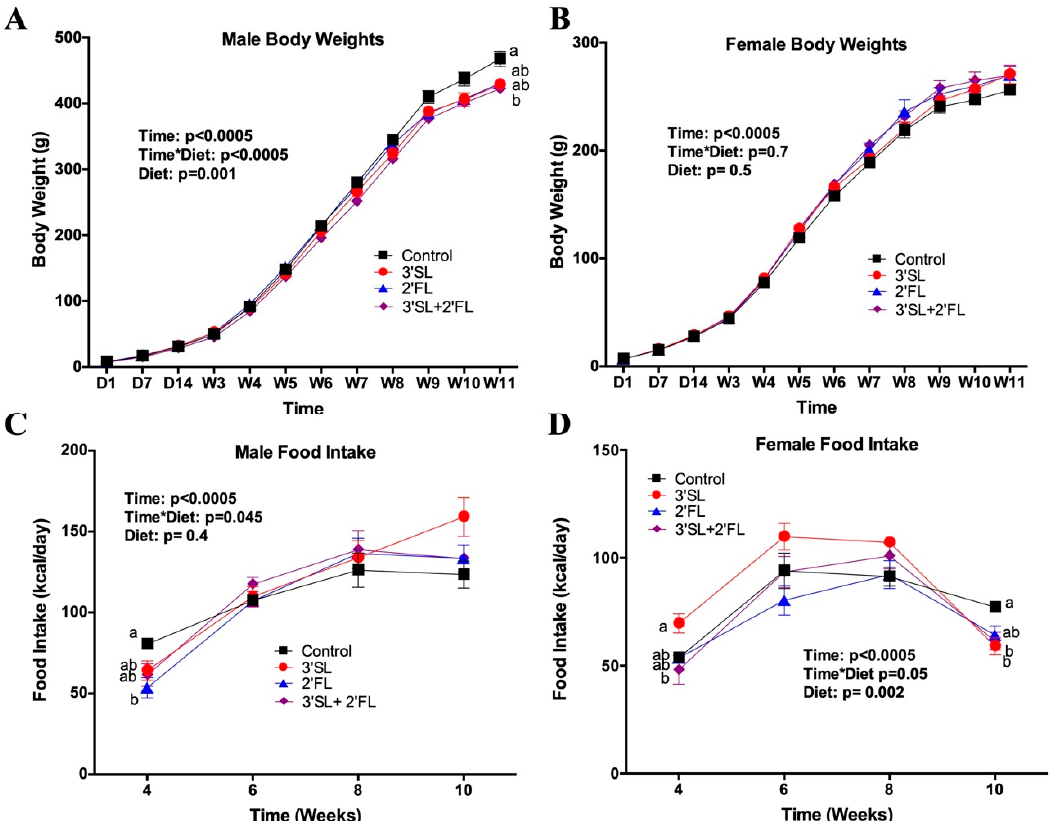
Figure 1. Body weight of ( A ) male and ( B ) female rats, as well as food intake for ( C ) male and ( D ) female rats fed the AIN-93 diet fortified with 3 (cid:48) sialyllactose (3 (cid:48) SL), 2 (cid:48) fucosyllactose (2 (cid:48) FL), both, or neither for eight weeks. Values are means ± standard error of the mean (SEM), n = 8–10. In the overall model, there was a significant sex e ff ect for body weight ( p = 0.001) and food intake ( p = 0.001); therefore, subsequent analysis was performed in males and females separately. Within males and females, the superscripts a, b are used to depict di ff erences between groups, where groups without a common superscript di ff er ( p < 0.05). Control: AIN-93; 3 (cid:48) SL: AIN-93 + 3 (cid:48) sialyllactose; 2 (cid:48) FL: AIN-93 + 2 (cid:48) fucosyllactose; 3 (cid:48) SL + 2 (cid:48) FL: AIN-93 + 3 (cid:48) sialyllactose + 2 (cid:48)